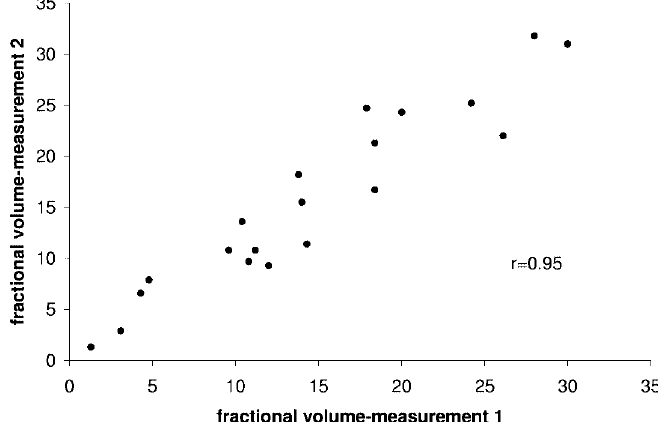
Fig. 4. Intra-observer reproducibility: results of duplicate assessment of fractional volume of S100 positive cells in 20 lymph node specimens.